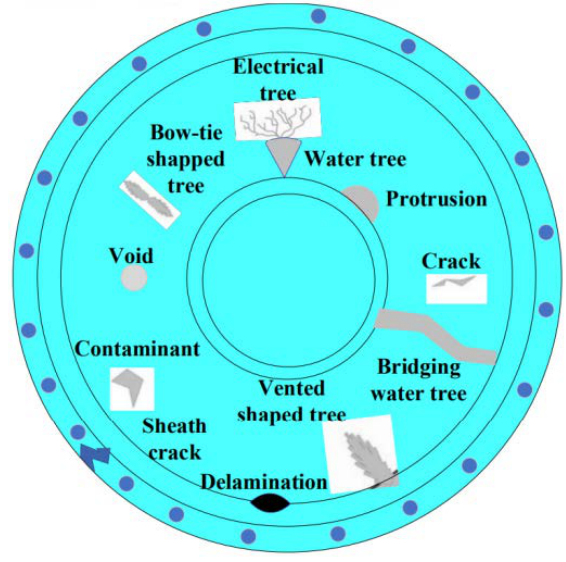
Figure 2. Typical defects in extruded power cables